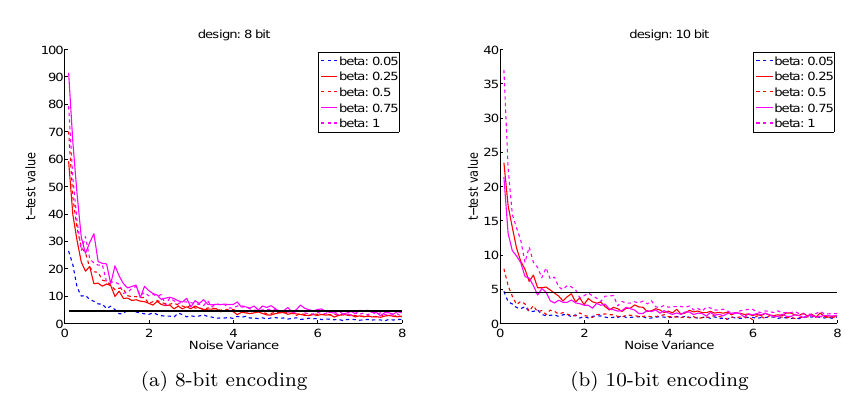
Figure 2: TVLA results for 8 to 10-bit encoding schemes with different noise levels